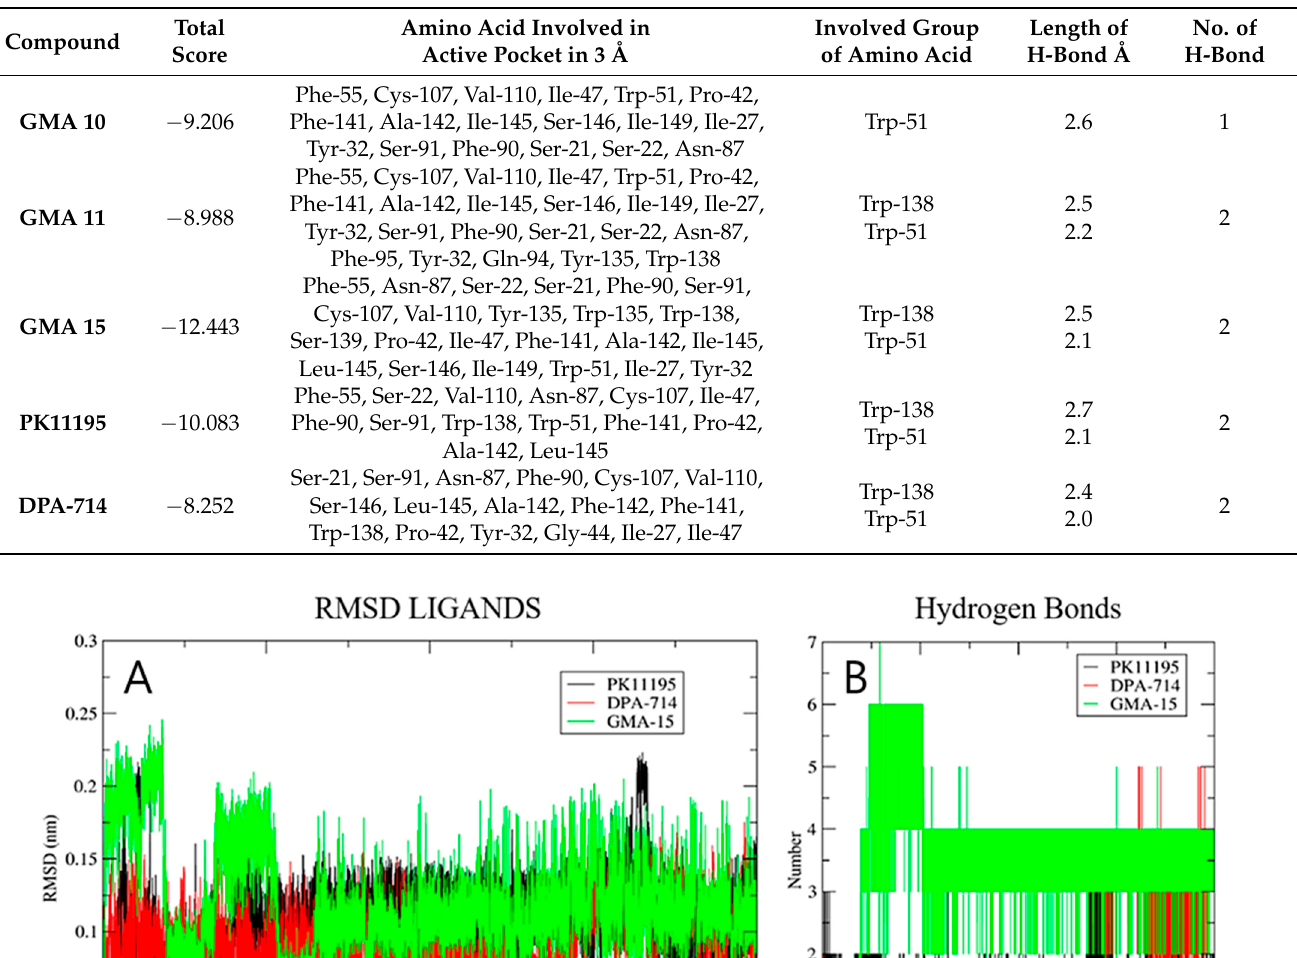
Table 2. Glide XP docking results of GMA 10 , GMA 11 , GMA 15 , PK11195 and DPA-714 with five binding sites of TSPO.